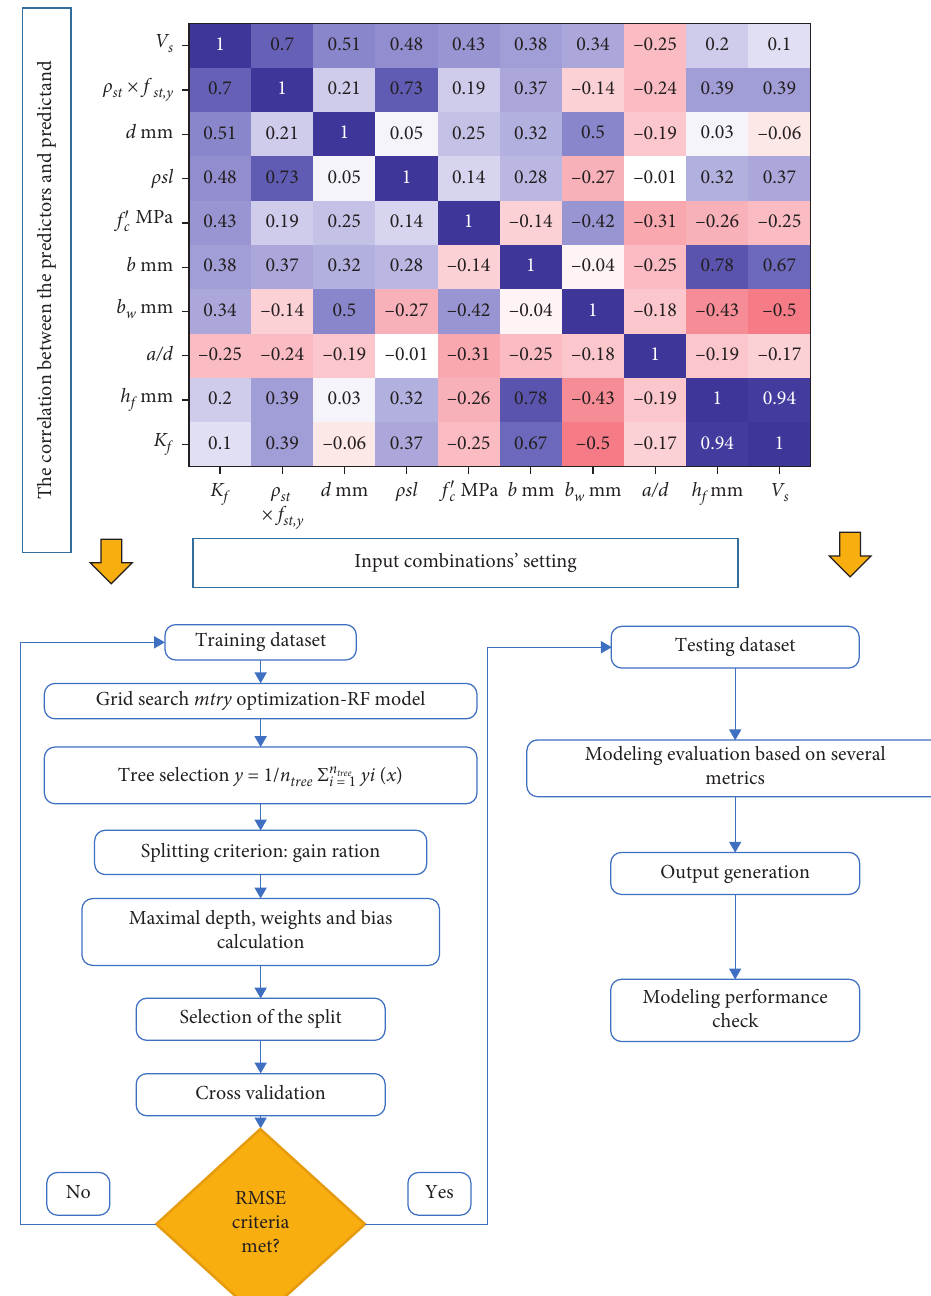
Figure 3: The modeling flowchart of the adopted AI model for the shear strength